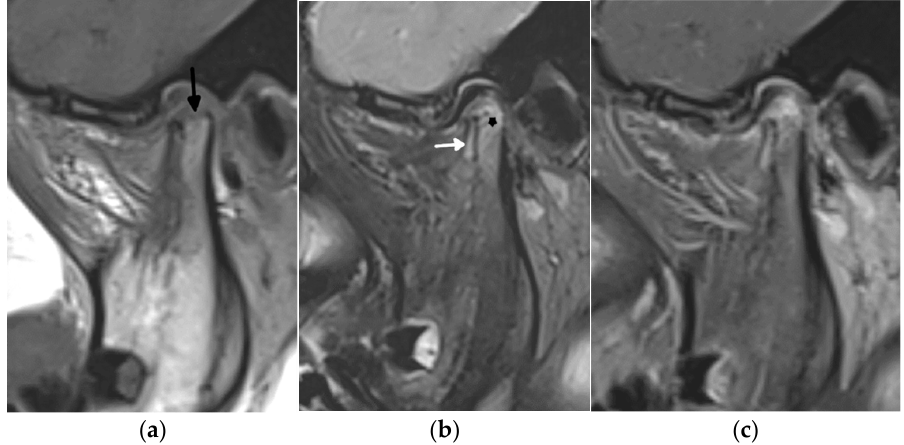
Figure 5. A 1.5 Tesla temporomandibular joint MRI with T1- ( a ), fat-saturated T2- ( b ), and post- contrast fat-saturated T1-weighted images ( c ) in a 7-year-old girl with juvenile idiopathic arthritis showing active and chronic inflammatory lesions: synovitis (white arrow), bone marrow edema in the mandibular condyle (star) in the upper part of the ramus, and erosions (black arrow).